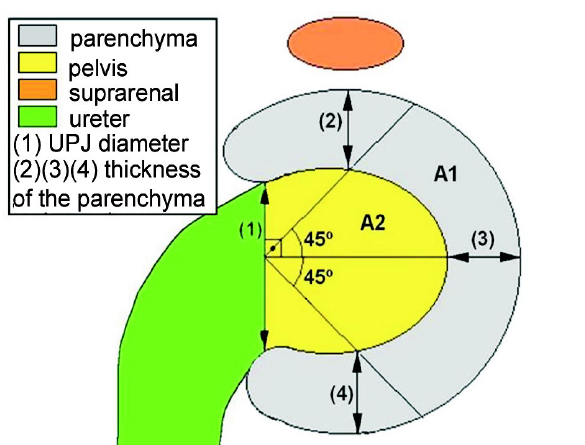
Figure 1 – Scheme used for performing the histomorphometric examination. 2-headed arrows indicate linear measurements. A1 = area of renal parenchyma and A2 = area of renal pelvis.